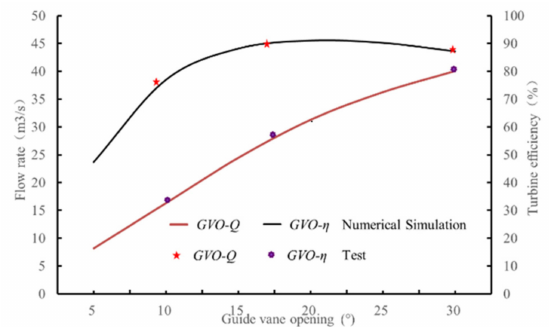
Figure 5. Reliability verification of external characteristics of hydraulic turbine.